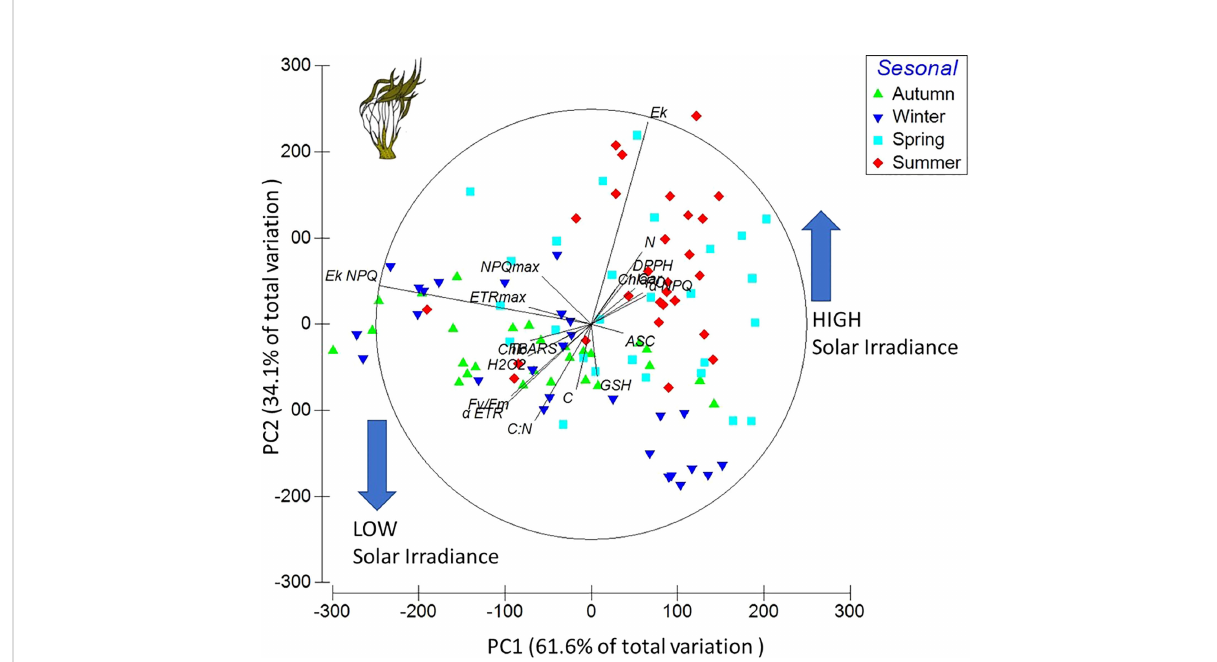
FIGURE 2 Principal components diagram based on 19 variables and treatment data from Lessonia spicata experiments. The ecophysiological variables considered were ETR max , a ETR , Ek, F v / F m , a NPQ , NPQ max , Ek NPQ , C, N, C:N, Chl a , Chl c , Car, PC, DPPH, H 2 O 2 , TBARS, GSH, and ASC.